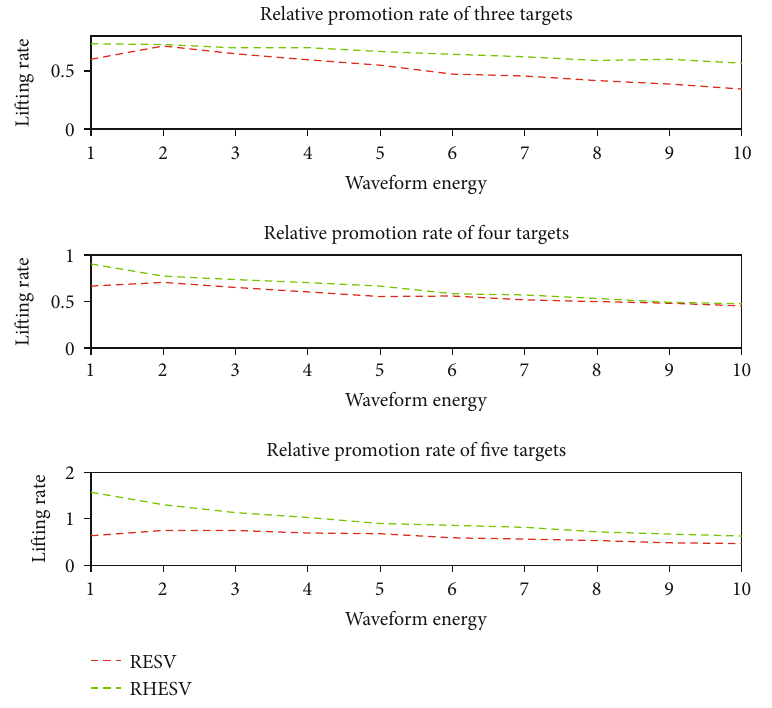
Figure 9: Comparison of relative lifting